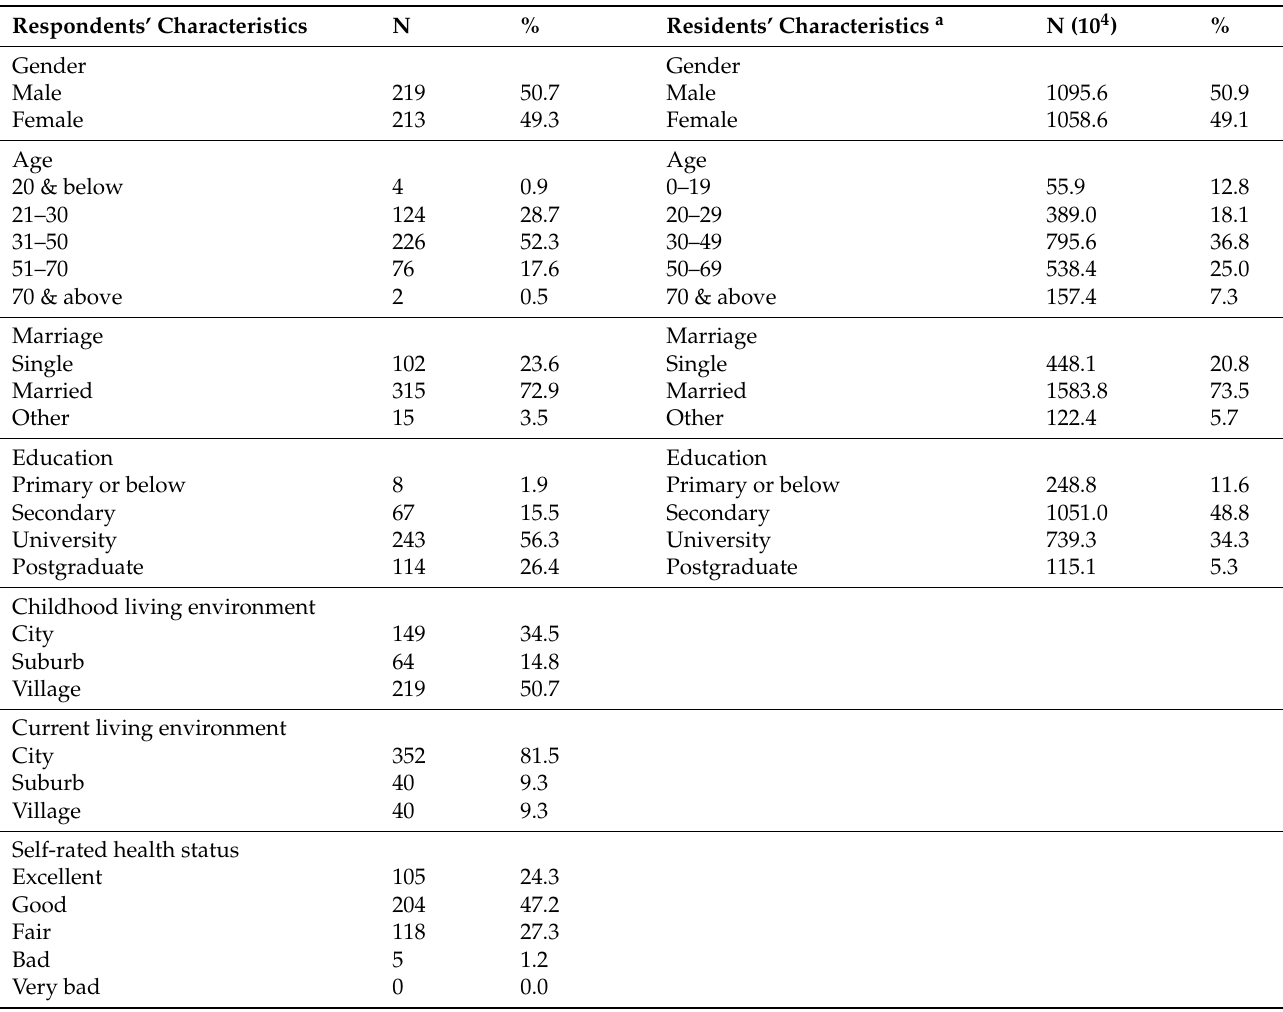
Table 2. Socio-demographic characteristics of the respondents compared with the residents in Beijing,